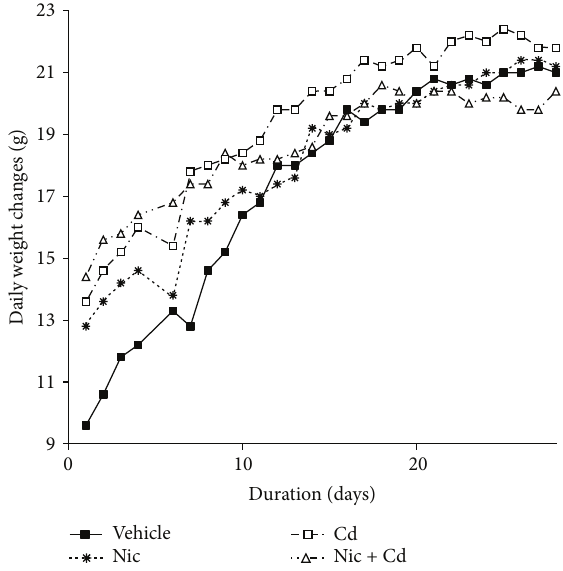
Figure 1: Spearman’s correlation showing the time-dependent weight changes in the treatment groups and control. The nicotine and/or cadmium treatment caused a significant increase in average weight from P28 to P56 when compared with the control. It was observed that nicotine-cadmium treatment induced a decline in weight around P37 versus saline administered mice statistically. This is suggestive that the weight loss associated with tobacco use is not an exclusive effect of nicotine, but an effect of combined nicotine and cadmium in tobacco